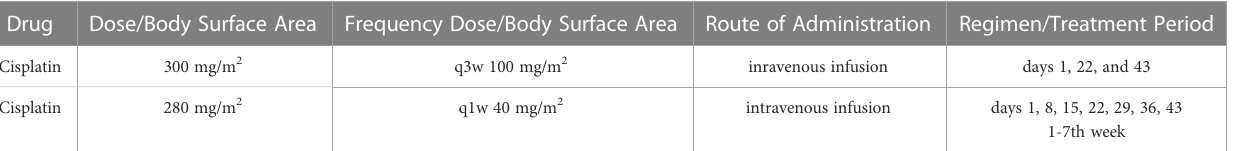
TABLE 2 Cisplatin